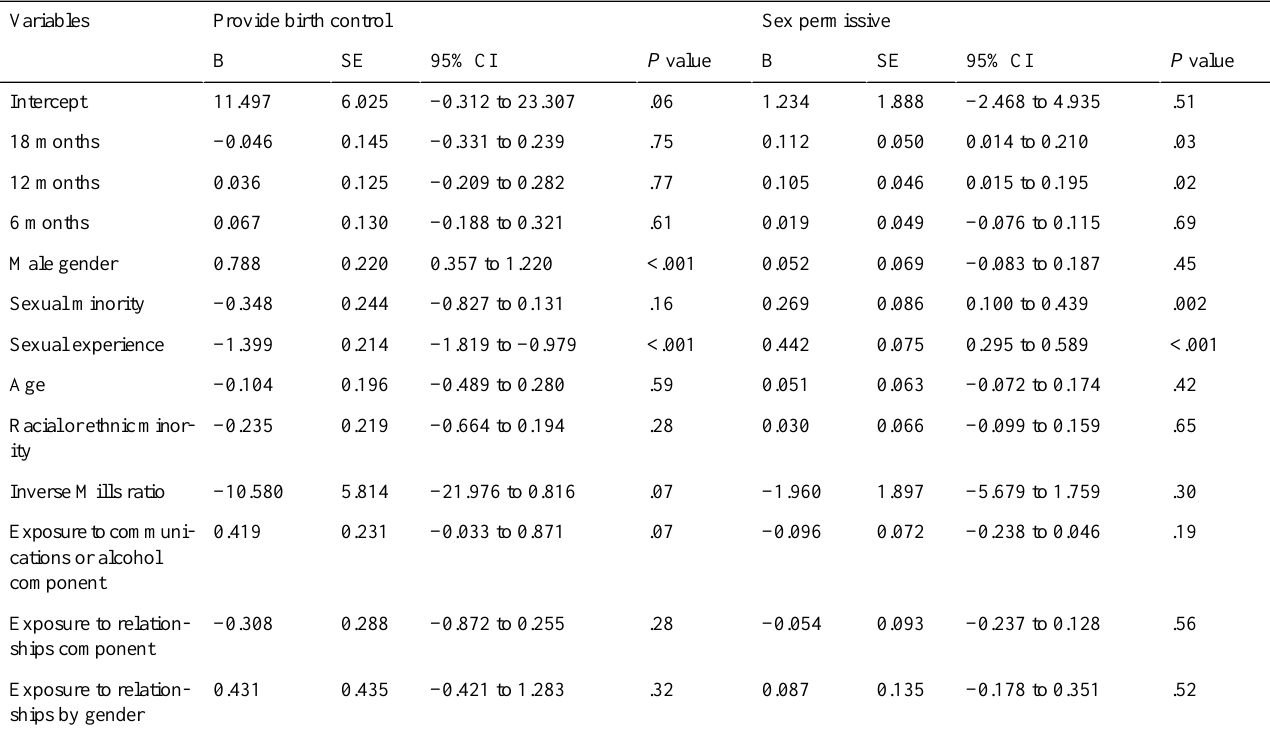
Table 7. Results from generalized estimating equations: interaction effects of intervention exposure on adolescent report of sexual communication by gender: positive communication (T0: n=411; T1: n=325; T2: n=311; T3: n=309).